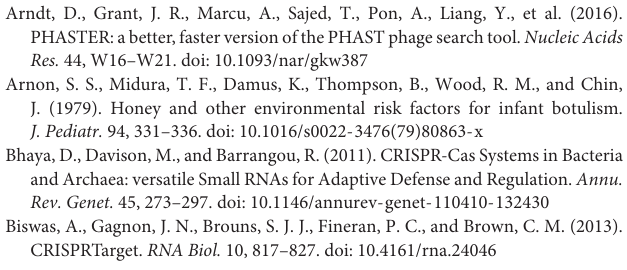
Supplementary Figure 1 | Cas6 protein alignment and phylogeny. Multiple alignment (Clustal Omega Default) (Sievers et al., 2011) and phylogenetic analysis (raxml -PROTGAMMAAUTO) (Stamatakis, 2014) of all Cas6 proteins identified within the study dataset indicates divergence between the type I-B systems present at genomic site 1, site 4, and plasmid-borne variants ( Supplementary File 5 ). Type III-B and III-D Cas6 form a single, high identity branch, while type III-A Cas6 proteins load on separate branches. All Cas6 loci are listed in Supplementary File 6 . Supplementary Figure 2 | Plasmid-borne bont gene clusters occur on a family of related conjugative plasmids. Plasmid pNPD7 and the putative integrated plasmid from C. sporogenes CDC 67071 share the conserved conjugation region present in most G1 C. botulinum bont ( + ) conjugative plasmids. Local alignment (blastN) of select bont ( + ) plasmids against pCBG; with a type I-B ∗ CRISPR-Cas system present at S5, a bont/A gene cluster at S6, and bont/B gene cluster at S7. A region of chromosome from C. botulinum IBCA10-7060 from 2339765–2389948 and a bont ( − ) conjugative plasmid pRSJ2_2 (NZ_CP013709.1) were additionally included. BRIG was run with pCBG set as the reference with the following settings: blastN, 70% upper identity threshold, 50% lower identity threshold, and annotated with site information (Alikhan et al., 2011). The bont genes and the type I-B ∗ gene clusters from pCBG are highlighted (red) within plasmid sites 5, 6, and 7 (gray) as defined in Figure 3 . (A) The type I-B ∗ CRISPR-Cas systems are present on all family plasmids except a subset of bont/A, B producing plasmids such as pCLJ. (B) The plasmid fragment adjacent to chromosomal bont/FA(H) at site 4 in strain ( Figure 3 ) is part of an insert unique to bont/A, B plasmids. (C) The bont/B1 plasmid is ∼ 100 kbp shorter than other family members and is missing the region including the putative conjugal type IV secretion system. (D) The bont ( − ) ∼ 200-kbp plasmids carrying the type I-B ∗∗ CRISPR-Cas system are unrelated to bont ( + ) 250-kbp plasmids. Supplementary Figure 3 | Full-length and/or fragmented group II introns near select subtypes of bont/A , B , and F gene clusters. (A) Local alignment (blastN default) of the plasmid-borne bont /A3 gene cluster in C. botulinum A3 Loch Maree against the chromosomal bont /A3 gene cluster in C. botulinum 1169. The CDS for the putative group II intron encoded protein (IEP) is annotated as ltrA . (B) Predicted secondary structure of the group II intron surrounding CDS ltrA in strain A3 Loch Maree with conserved domains (I–VI) labeled. (C) Location of a ltrA fragment present at the arsC disruption site in a subset of chromosomally integrated bont /A and F gene clusters. (D) Multiple alignment of full-length ltrA genes and ltrA fragments from representative strains (Clustal omega, default settings). (E) Phylogenetic distribution of ltrA fragments (filled blue circle) and full-length ltrA genes (filled red square) across the study strains. ∗ Primary hit: